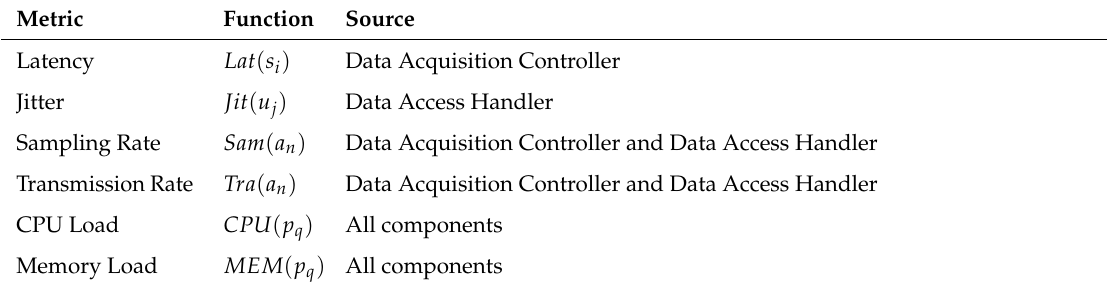
Table 4. QoS metric definition and their corresponding